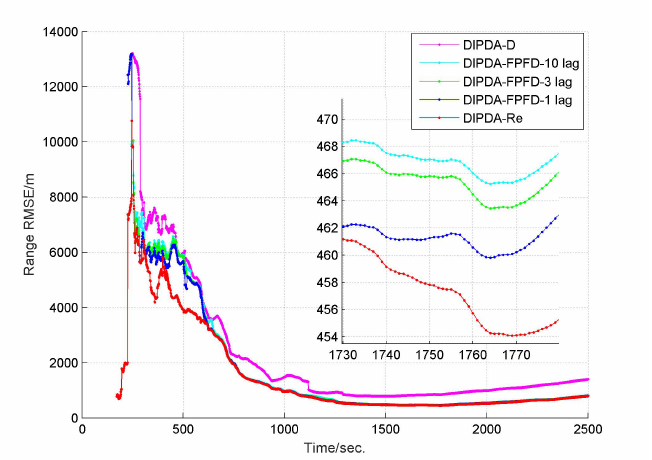
Figure 13. Averaged number of CTTs of DIPDA-D, DIPDA-Re, DIPDA-FPFD with different lags (case 3).